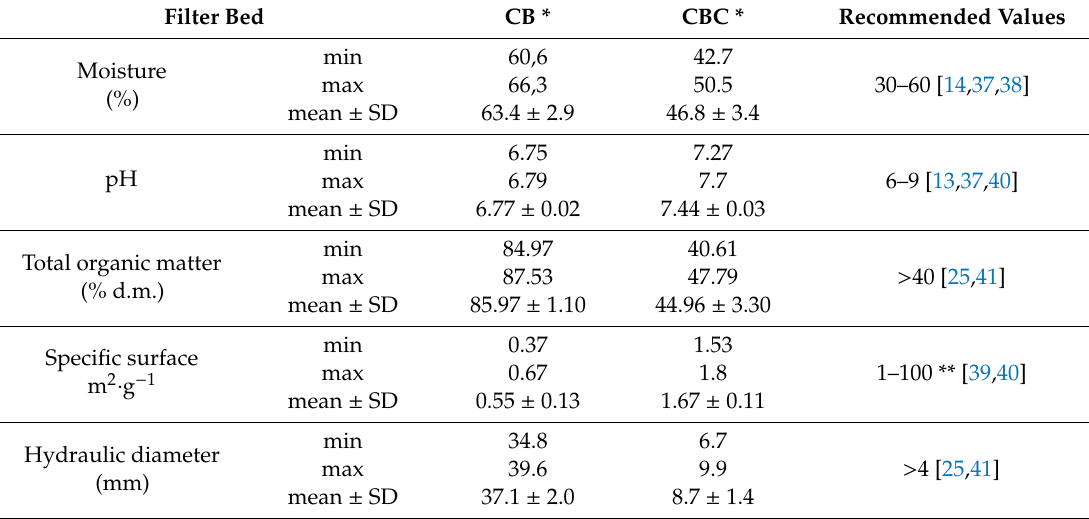
Table 5. Technical parameters of the biofilter filling materials – values for each measurement series and mean values.